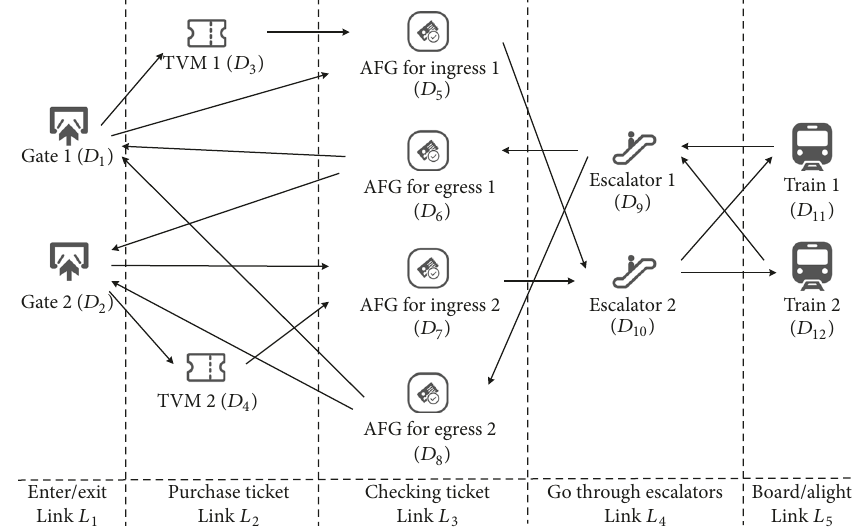
Figure 2: The association network of facilities in nontransfer